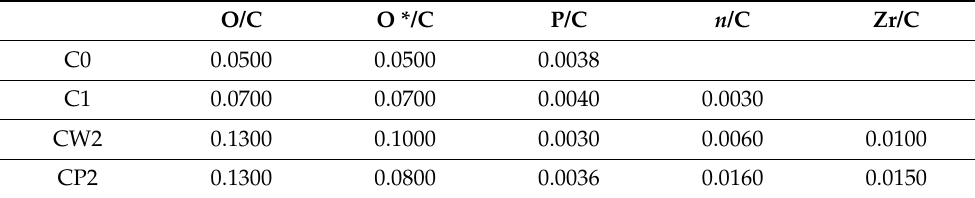
Table 1. Composition of elements in AC fractions according to